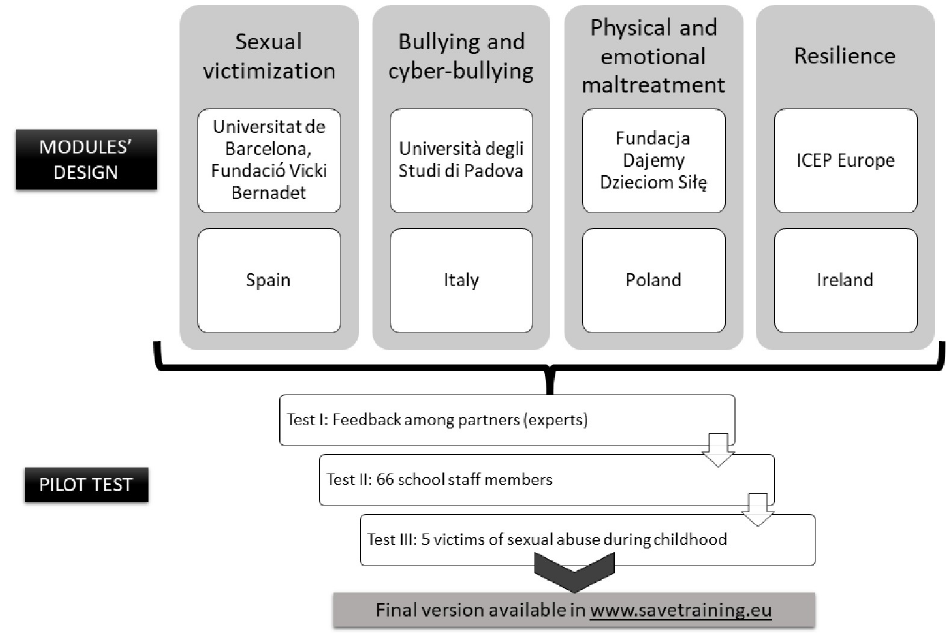
Fig 1. Design and testing of SAVE course. Each module was composed of an introduction page, a real story, definition, prevalence, signs to detect potential cases, what to do, reporting procedures, prevention, self-assessment, summary and